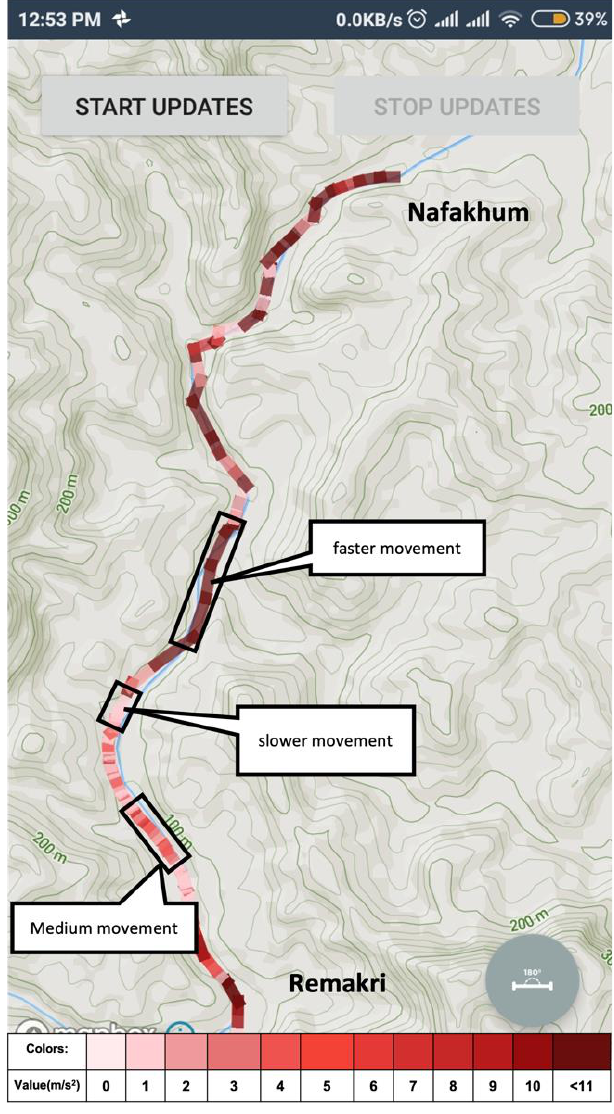
Figure 8. This shows that a user created a path of an unknown area from Remakri to Nafakhum falls. A new tracker can follow the route and get a clear idea of the route path through color intensity. A newbie tracker will not be lost on that hill tracks area because this map will work offline